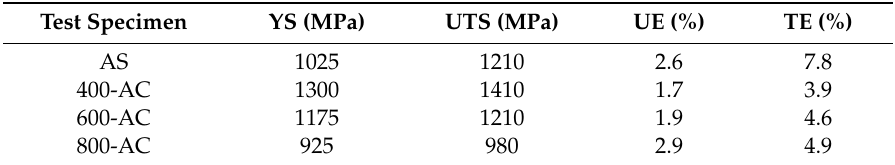
Figure 7. Tensile properties of AS, 400-AC, 600-AC, and 800-AC at room temperature for ( a ) strength and ( b ) ductility. Table 4. Room temperature tensile properties of AS, 400-AC, 600-AC, and 800-AC. (YS: yield strength;